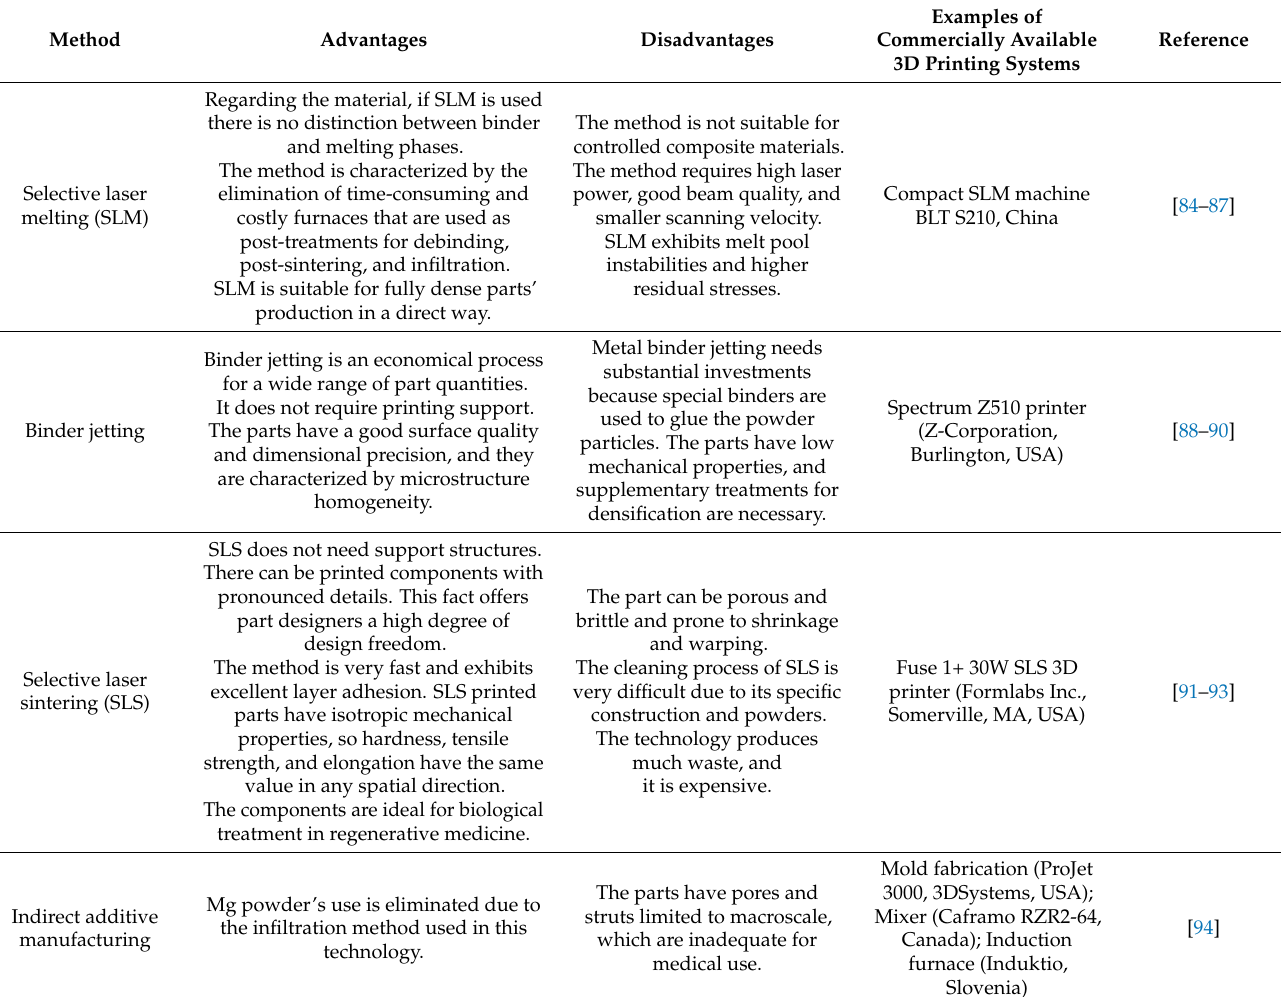
Table 3. Advantages and disadvantages of the AM technology used for Mg-based scaffolds’